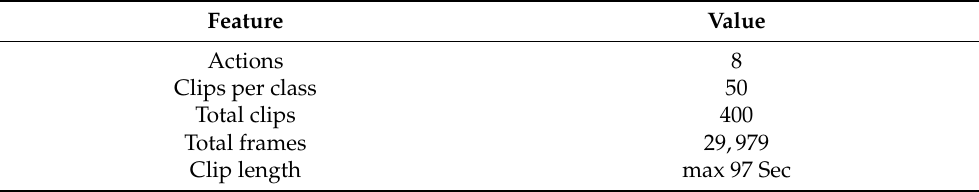
Table 1. Summary of YouTube-Aerial dataset.